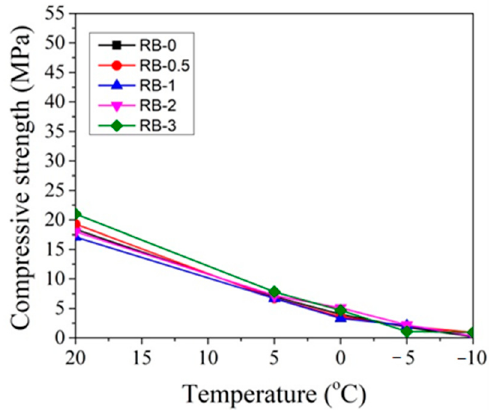
Figure 21. Compressive strength of concrete samples with CEM IIN after 2 days as a function of initial curing temperatures (°C) for CN at dosages from 0% to 3%.